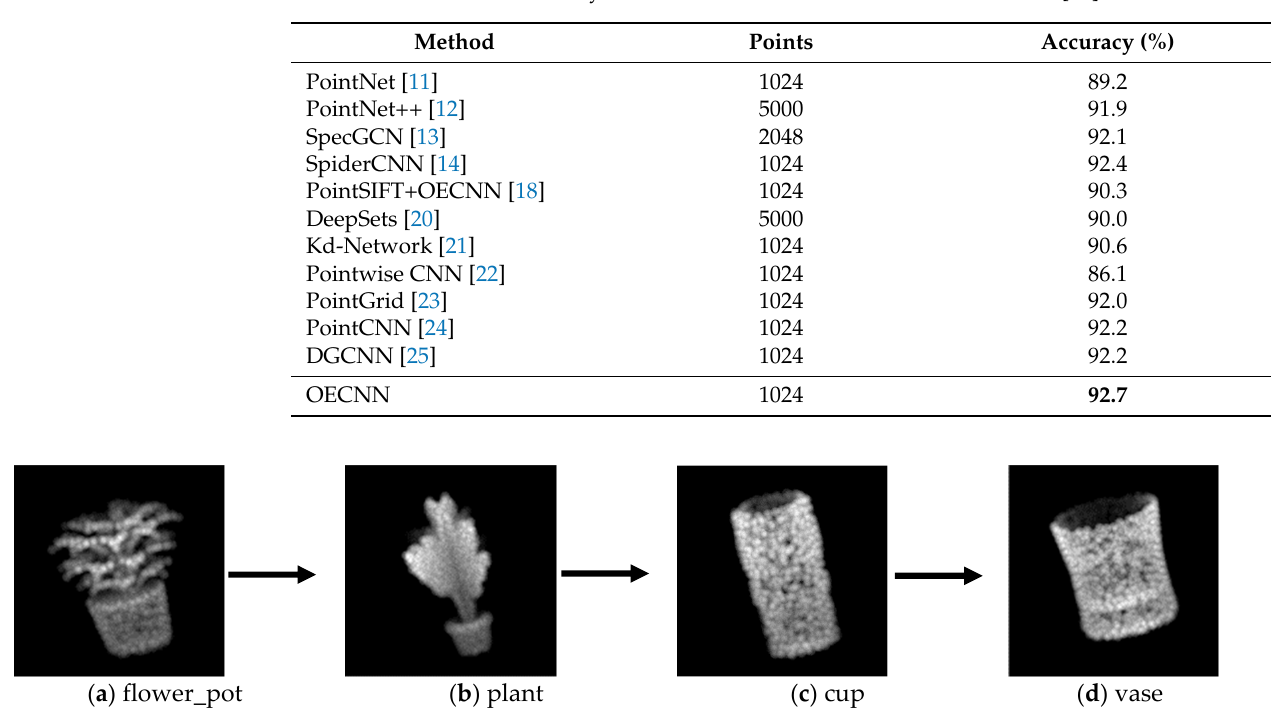
Figure 8. The visualization of misclassified samples on ModelNet40 [19]. Table 1. Classification accuracy of OECNN and other models on ModelNet40 [19].